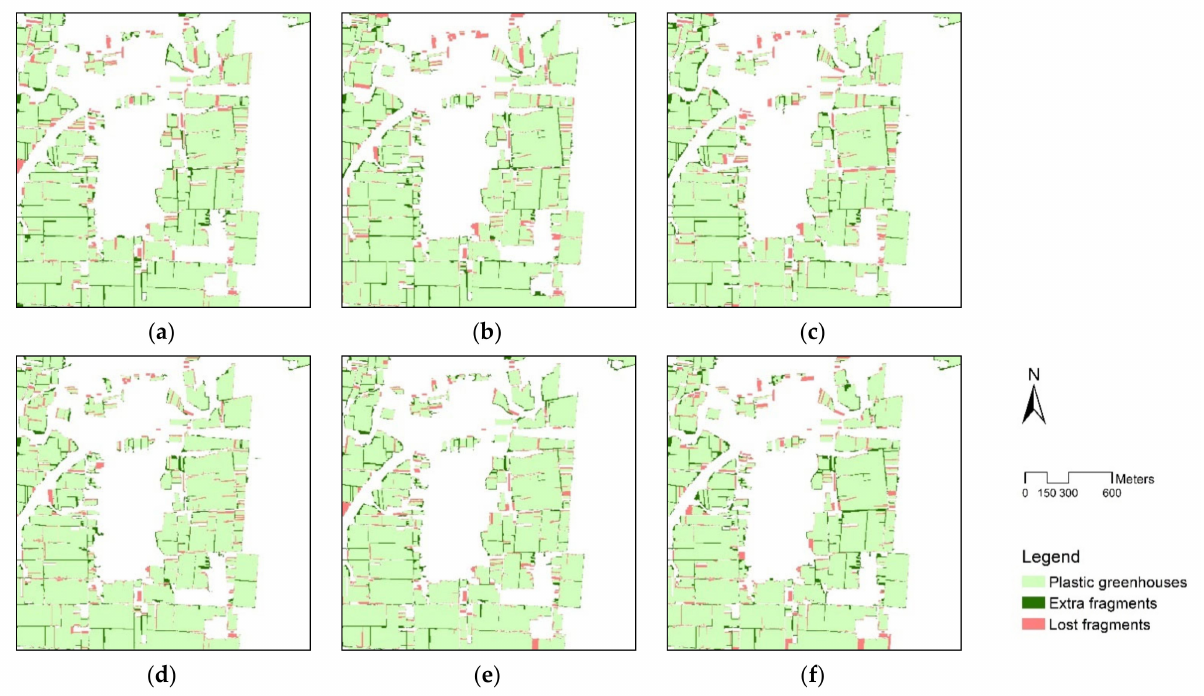
Figure 9. Effects of spatial filtering on PG extraction results of ACFI compressed to MDN 255: ( a ) GLP